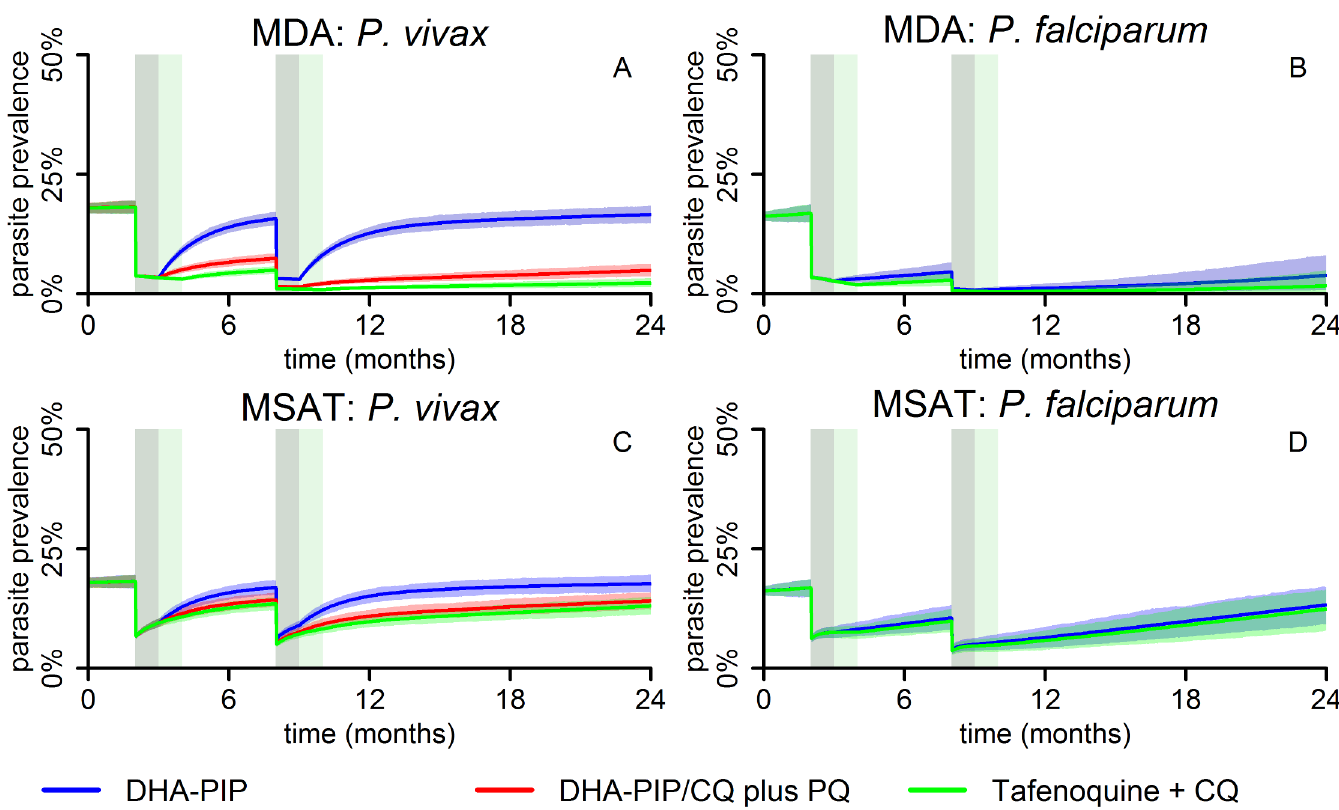
Fig 6. Mathematical-model-based predictions of impact of MDA and MSAT with either blood-stage drugs only or blood- plus liver-stage drugs on the population prevalence of P . vivax and P . falciparum infections. The effect of two rounds (6 mo apart) of MDA (A and B) or MSAT (C and D) with anti- malarial drugs at 80% coverage on P . vivax (A and C) and P . falciparum (B and D) blood-stage parasite prevalence, as predicted by a stochastic model in a human population of size 5,000. The lines represent the mean of 1,000 repeat simulations, and the shaded areas represent the envelopes containing 95% of stochastic simulations. The grey and green shaded bars denote the duration of prophylactic protection for DHA-PIP/CQ and tafenoquine, respectively, after each treatment round. DHA-PIP and CQ were assumed to be administered as part of a 3-d regimen, providing prophylaxis for 1 mo. PQ was assumed to be administered as part of a 14-d regimen, providing prophylaxis for 15 d. Tafenoquine was assumed to be administered via a single dose, providing prophylaxis for 2 mo.